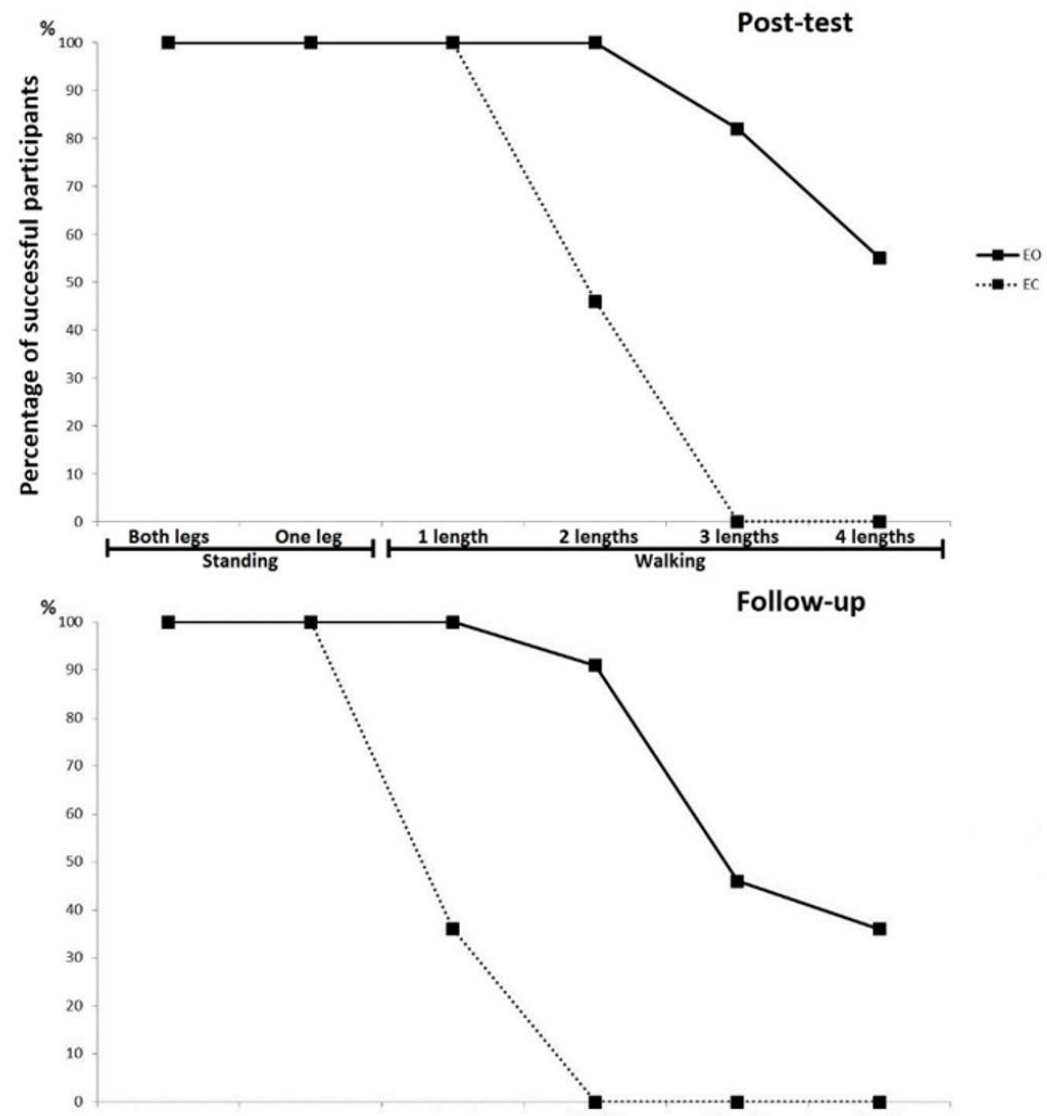
Figure 1. Percentage of participants who successfully achieved listed tasks at the post-test and follow-up for both groups. Table 2. Percentage of participants who successfully achieved task-specific learning requirements.